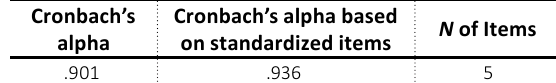
Table 4. Cronbach’s